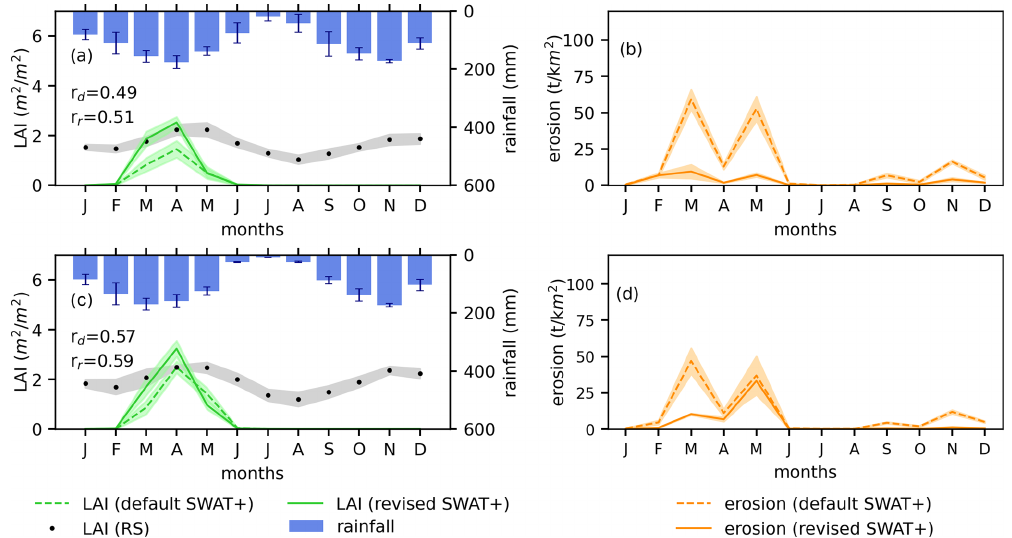
Figure 7. Monthly mean and standard deviation (bands) of LAI (a, c) and erosion (b, d) comparison for rainfed wheat and irrigated wheat, respectively, in the Victoria Basin. The LAI correlation coefficients ( r d for the default SWAT + model and r r for the revised SWAT + model) are